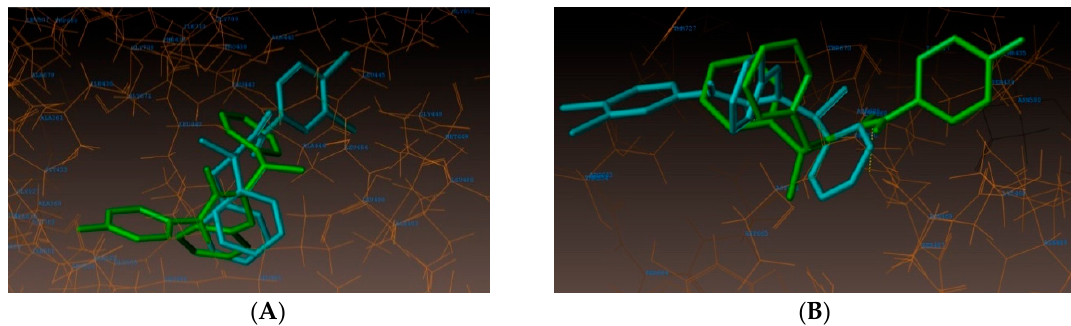
Figure 5. ( A ) Docked views of 3UDI_ligand. ( B ) Docked view of 3UDI_ligand at the active site of enzyme PDB ID: 3UDI. ( C ) Neighboring interactions of 3UDI_ligand. Antibiotics 2019 , 8 , x